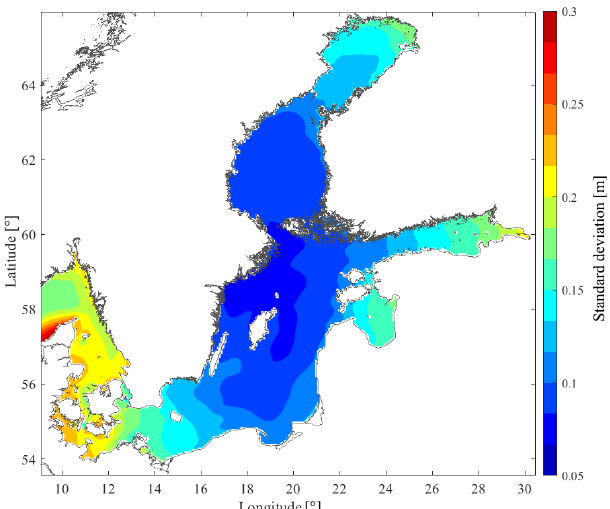
Figure 8. Normalized annual energy absorption as a function of the SL for a L12 Uppsala WEC and for a sea state characterized by H s = 1m and T e = 5s. The markers indicate the results of the hydro-mechanic simulations, while the solid line serves as a guide to the eye. Adapted from Castellucci et al.